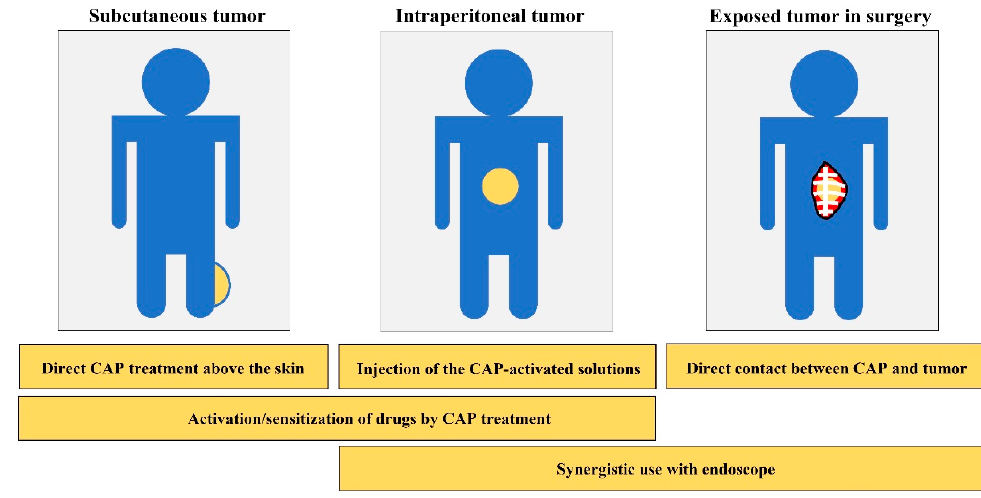
Figure 5. Schematic illustration of possible means to use CAP in clinical cancer therapy.